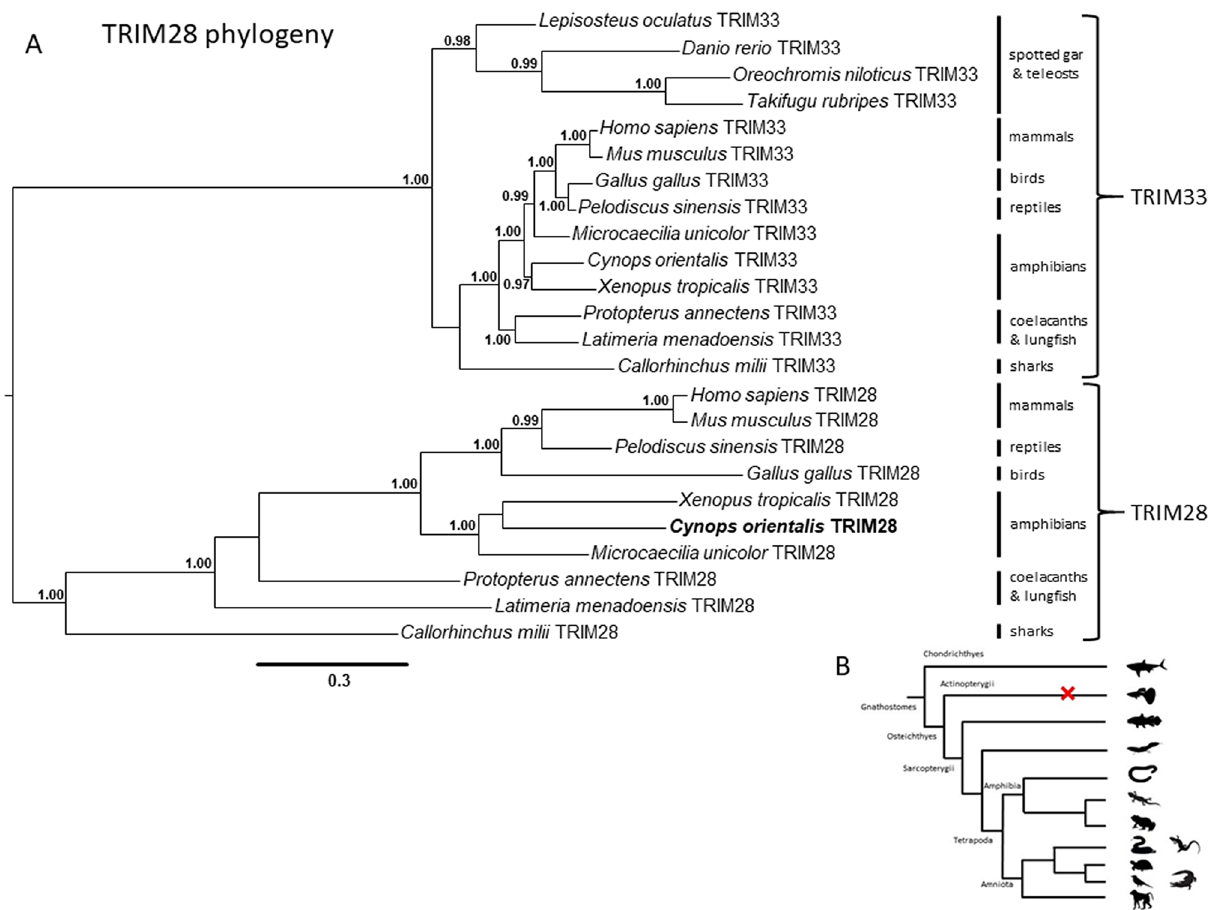
Figure 6. TRIM28 phylogeny. (A) Phylogenetic analysis of TRIM28 performed through Bayesian inference. The two curly brackets group TRIM33 and TRIM28 sequences. Vertical bars indicate to which animal group the sequences analysed belong to. (B) Schematic representation of TRIM28 evolutionary history in gnathostomes. Red cross indicates gene loss. Cynops orientalis TRIM28 is in